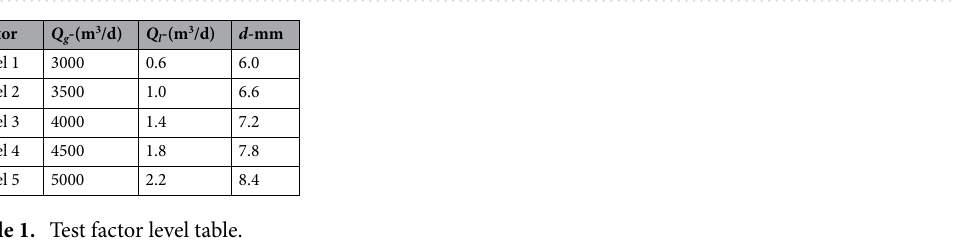
Table 1. Test factor level